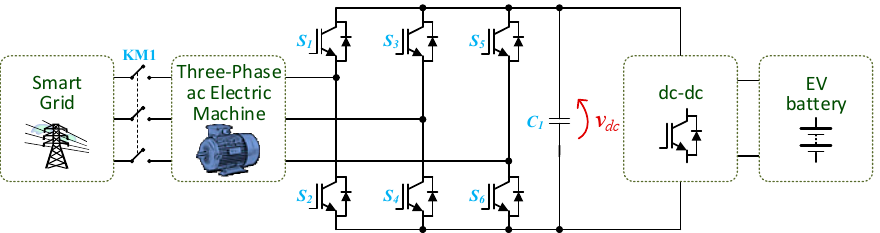
Figure 25. Unified power converter topology based on open-end winding ac electric machines (with Figure 25. Unifiedpowerconvertertopologybasedonopen-endwindingacelectricmachines(withaccess access to all winding’s terminals). to all winding’s